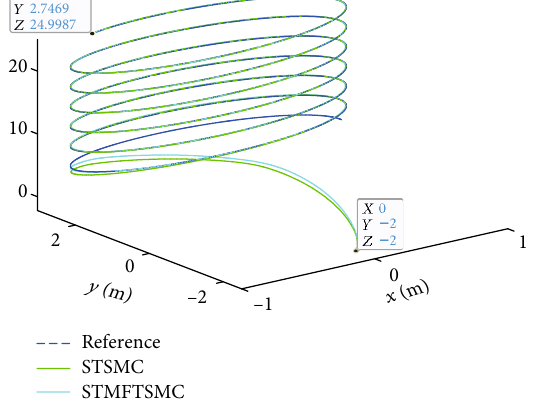
Figure 6: Quadrotor control